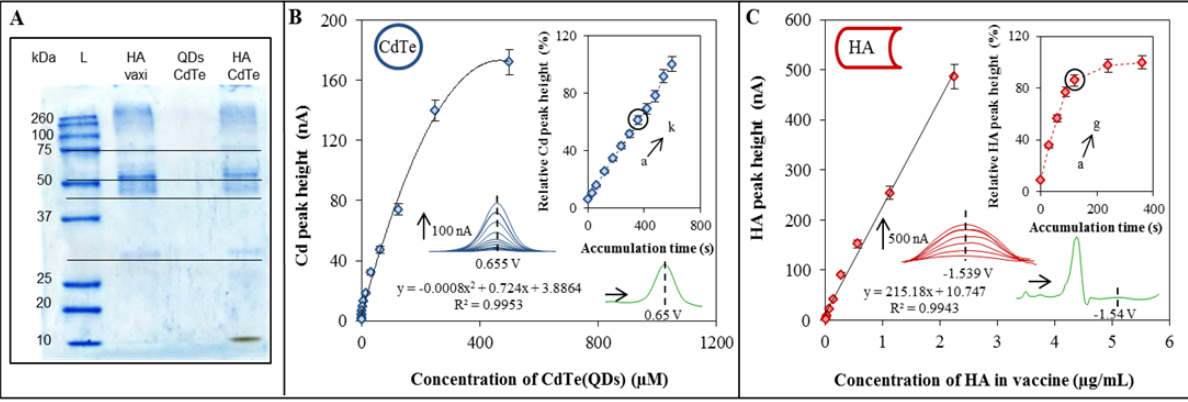
Figure 1. Characterization of QDs and hemagglutinin by gel electrophoresis and electrochemical analysis. ( A ) Characterization of vaxi HA, CdTe and vaxi HA-CdTe by gel electrophoresis (SDS PAGE). Concentration of labeled and non-labeled vaxi HA was 22.5 µg/mL, concentration of CdTe was 500 µM; ( B ) Electrochemical detection of individual parts of HA-CdTe complex. Dependence of Cd peak height on Cd (CdTe) concentration. Inset: dependence of relative Cd peak height (related to the maximum value) on time of accumulation. Cd was determined by DPASV with parameters as it follows: initial potential − 0.8 V; end potential -0.5 V; deposition potential -0.8 V; equilibration time 5 s; modulation time 0.06 s; time interval 0.2 s; potential step 0.002 V; modulation amplitude 0.025 V. Time of accumulation was optimized (a  k): a 30 s, b 60 s, c 120 s, d 180 s, e 240 s, f 300 s, g 360 s, h 420 s, i 480 s, j 540 s, and k 600 s; ( C ) Dependence of HA peak height on HA (vaxi HA) concentration. Inset: dependence of relative HA peak height (related to the maximum value) on time of accumulation. For measurement AdT DPV Brdicka reaction was used under following parameters: purge time 30 s; initial potential − 0.7 V; end potential − 1.8 V; potential step 0.002 V; amplitude 0.025 V. Time of accumulation was optimized (a  g): a 0 s, b 30 s, c 60 s, d 90 s, e 120 s, f 240 s, and g 360 s. Concentration of vaxi HA was 2.25 µg/mL, initial concentration of CdTe was 500